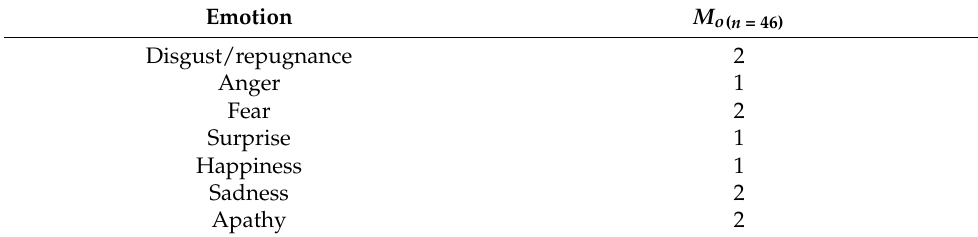
Table 3. Descriptive statistics by emotional variable.